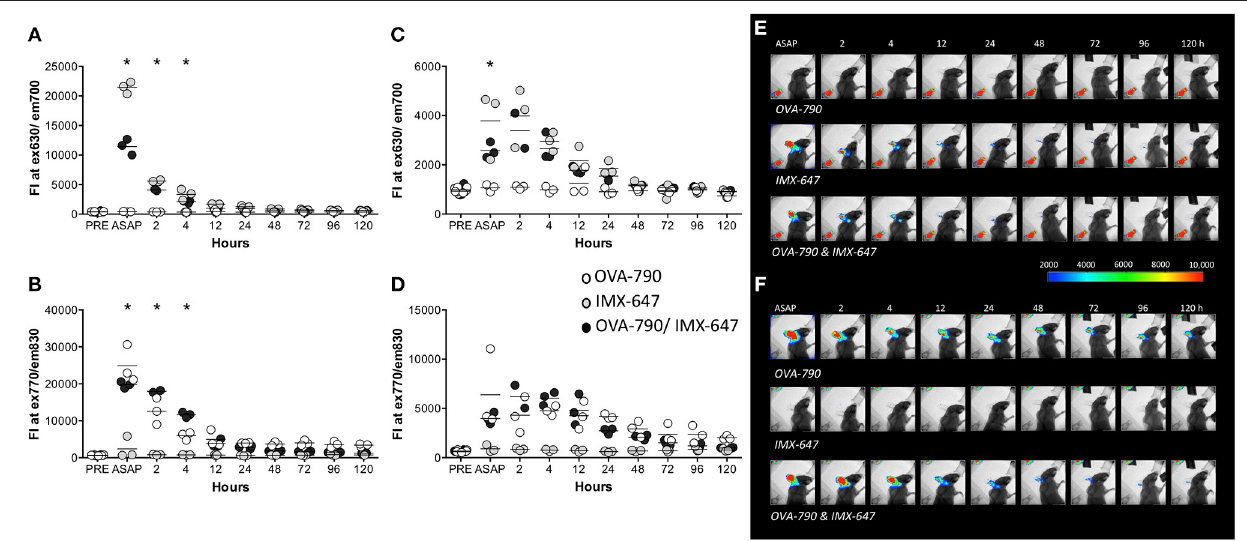
FIGURE 1 | ISCOMATRIX does not alter the passage of soluble antigen from the injection site to the lymph node. Graphs show fluorescence intensity of (A) ISCOMATRIX-647 detected at 630 ± 17.5nm and (B) OVA-790 detected at 830 ± 17.5nm in the ear pinnae and (C) ISCOMATRIX-647 and (D) OVA-790 in the draining cervical lymph node over time. Representative X-ray images with pseudocoloured fluorescence images overlaid showing (E) ISCOMATRIX-647 fluorescence (630 ± 17.5nm) and (F) OVA-790 fluorescence (830 ± 17.5nm) over time following injection in the ear pinnae with OVA-790 alone, ISCOMATRIX-647 alone or OVA-790/ISCOMATRIX-647. Three animals were imaged at each time point. IMX = ISCOMATRIX TM adjuvant, * P <